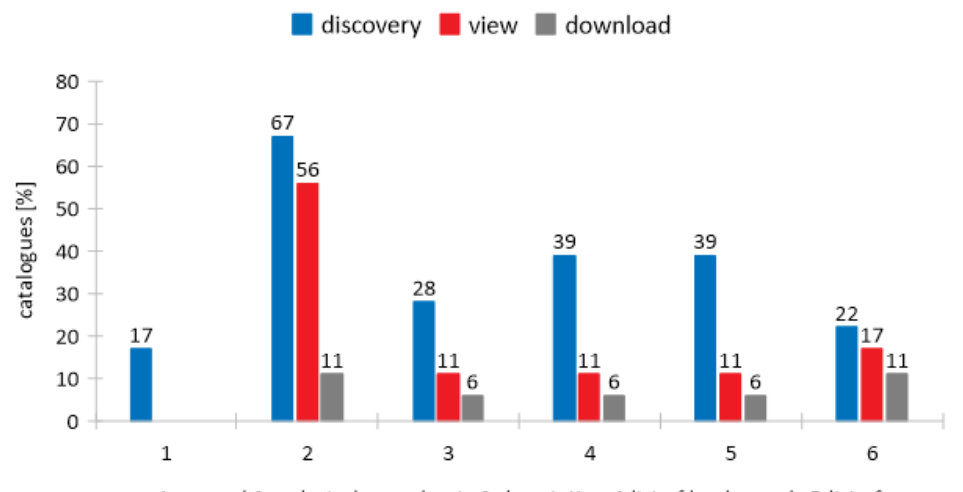
Figure 4. Availability of cadastral documents from the Franciscan Cadastre in catalogs through services. Source: Own compilation.